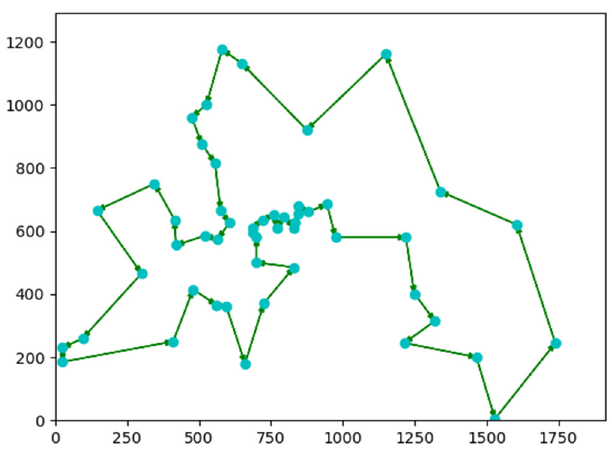
Figure 15. DTLBO solution for Berlin52.